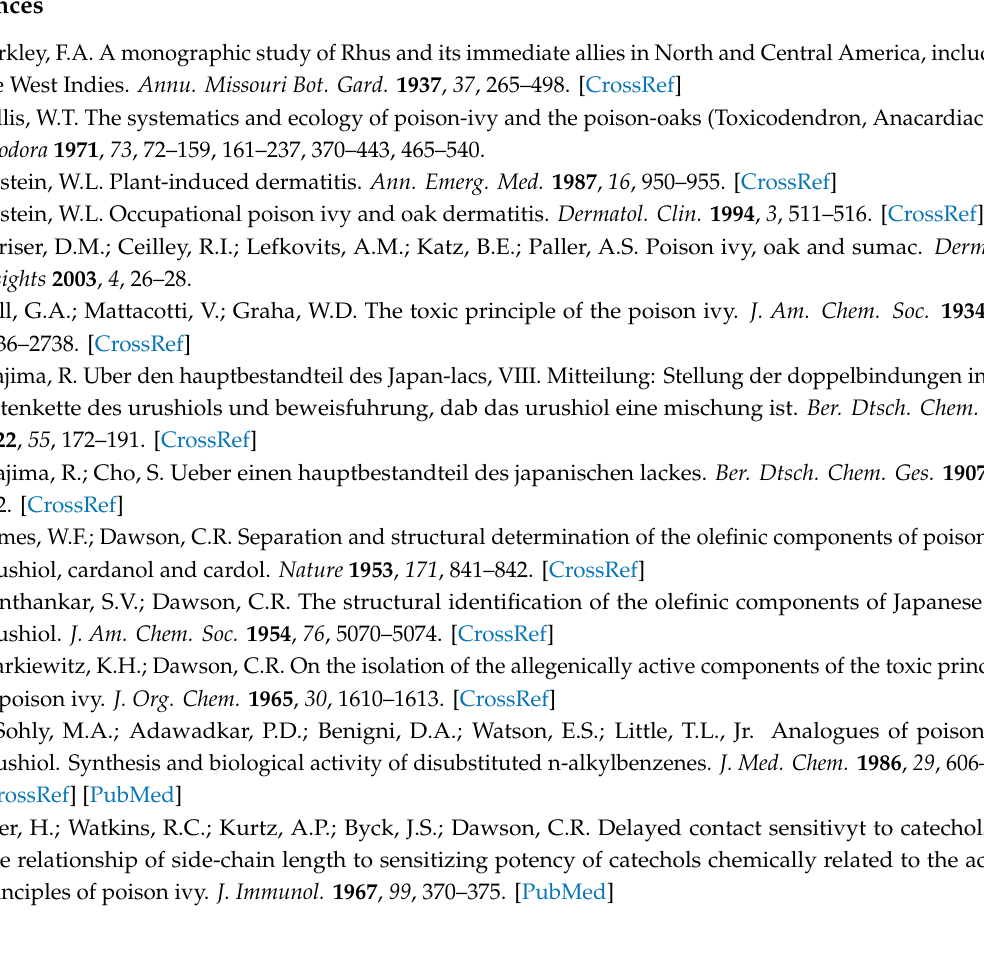
Supplementary Materials: The following are available online, Figure S1. Selective ion chromatograms of C15- and C17-urushiol congeners and isomers. Table S1. Pearson correlation results for all C15-cardanol, C15-urushiol, and C17-urushiol congener and isomer